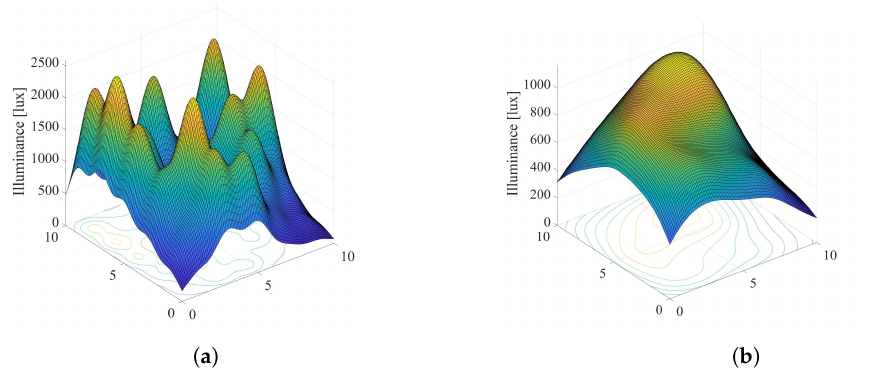
Figure 4. Overallillumination a randomly selected dimming vector, 0 ≤ s i ≤ 1, i = 1, . . . , N . ( a ) Φ 1/2 = 20 0 . ( b ) Φ 1/2 = 60 0